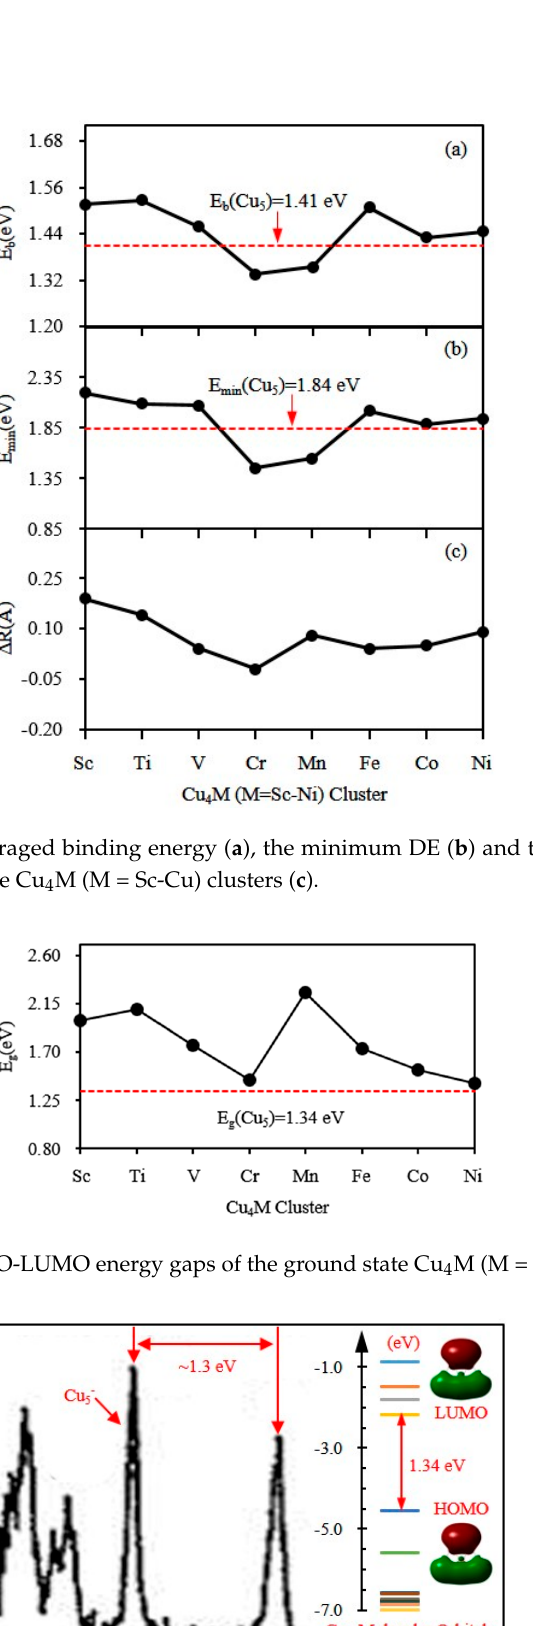
Figure 5. The experimental PES spectrum of Cu 5 − cluster, which is cited from Ref. [64].